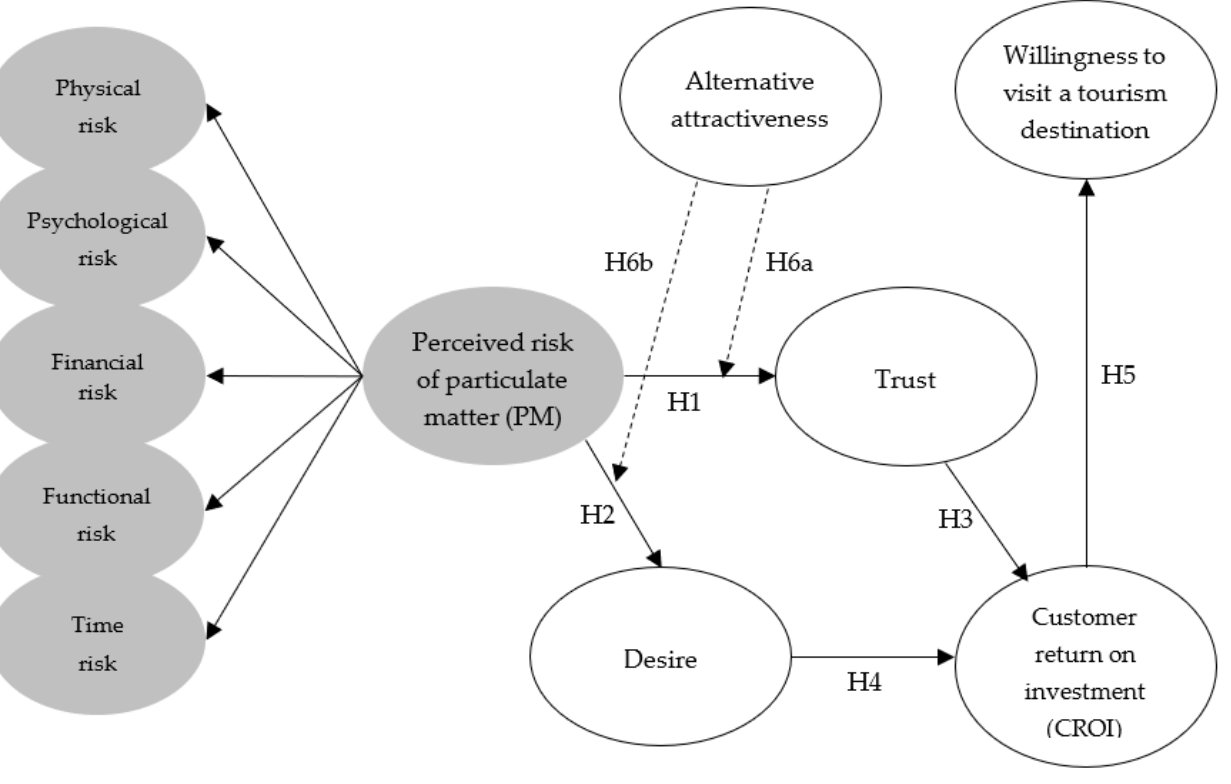
Figure 1. Research Figure 1. Research model.